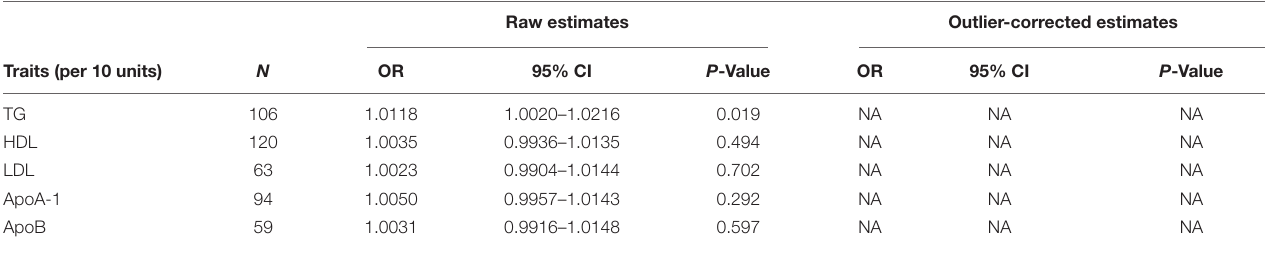
TABLE 4 | Mendelian randomization pleiotropy residual sum and outlier test (MR-PRESSO) estimates between lipid profiles and SA. Raw estimates Outlier-corrected